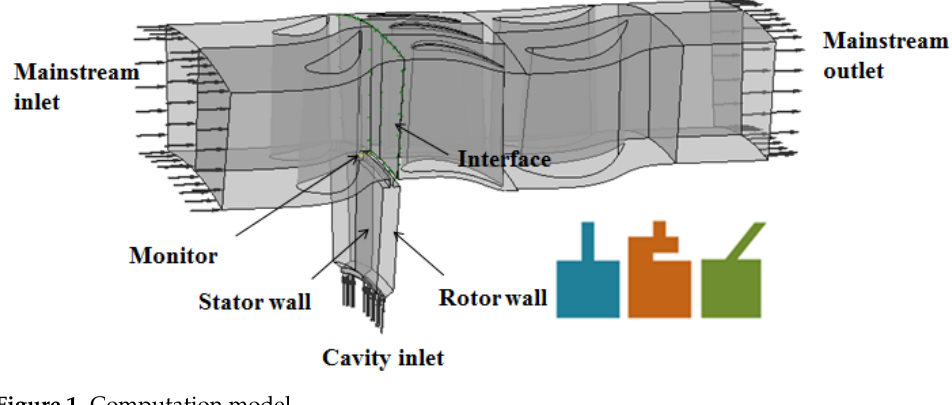
Figure 1. Computation model. Table 1. Geometric and aerodynamic parameters of each blade row of a Lisa stage 1.5 turbine.